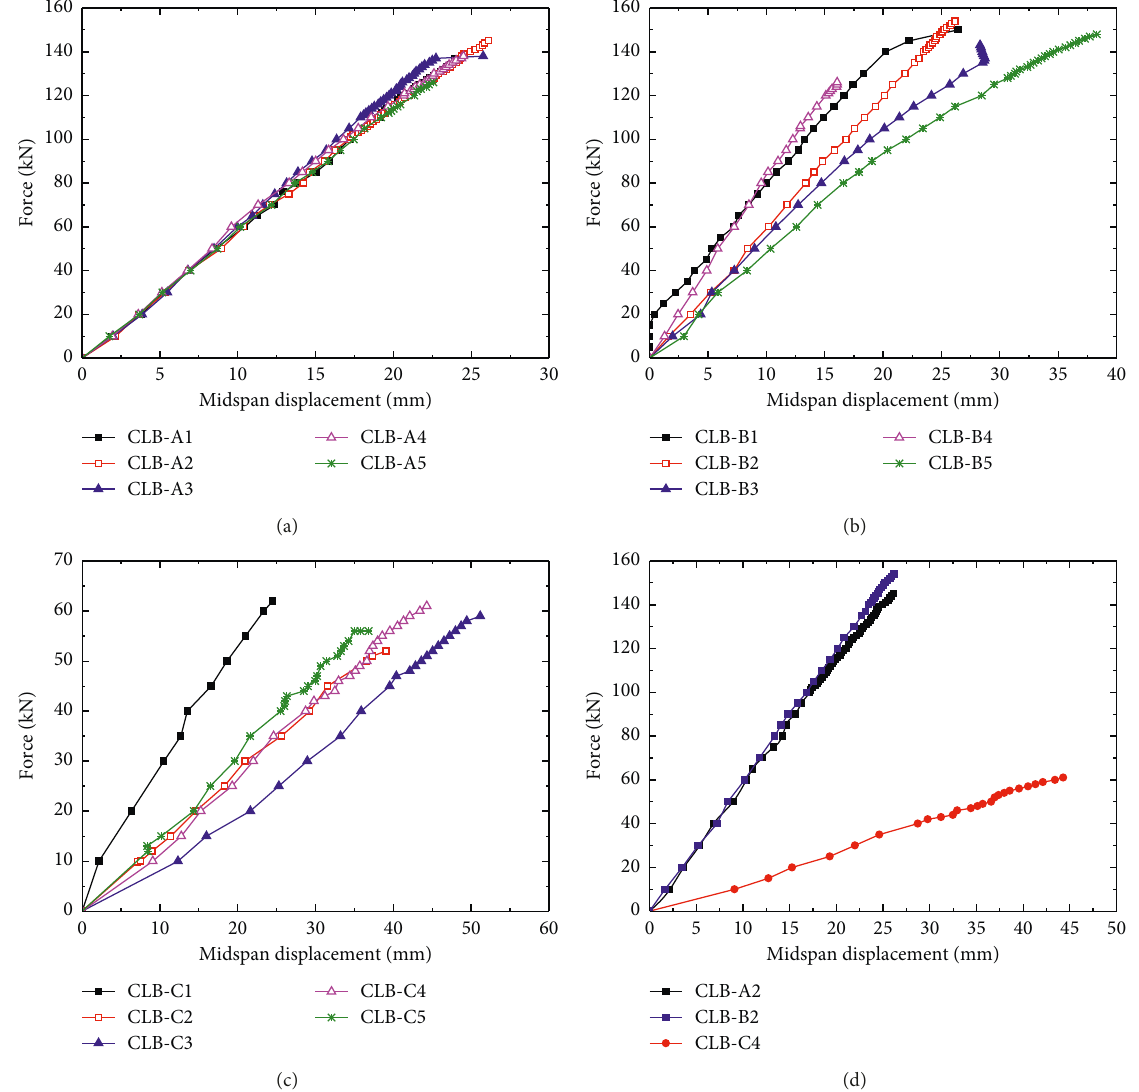
Figure 17: Load-midspan displacement curves of CLB slabs without CFRP grids. (a) Group CLB-A. (b) Group CLB-B. (c) Group CLB-C. (d) Comparison of groups CLB-A, CLB-B, and